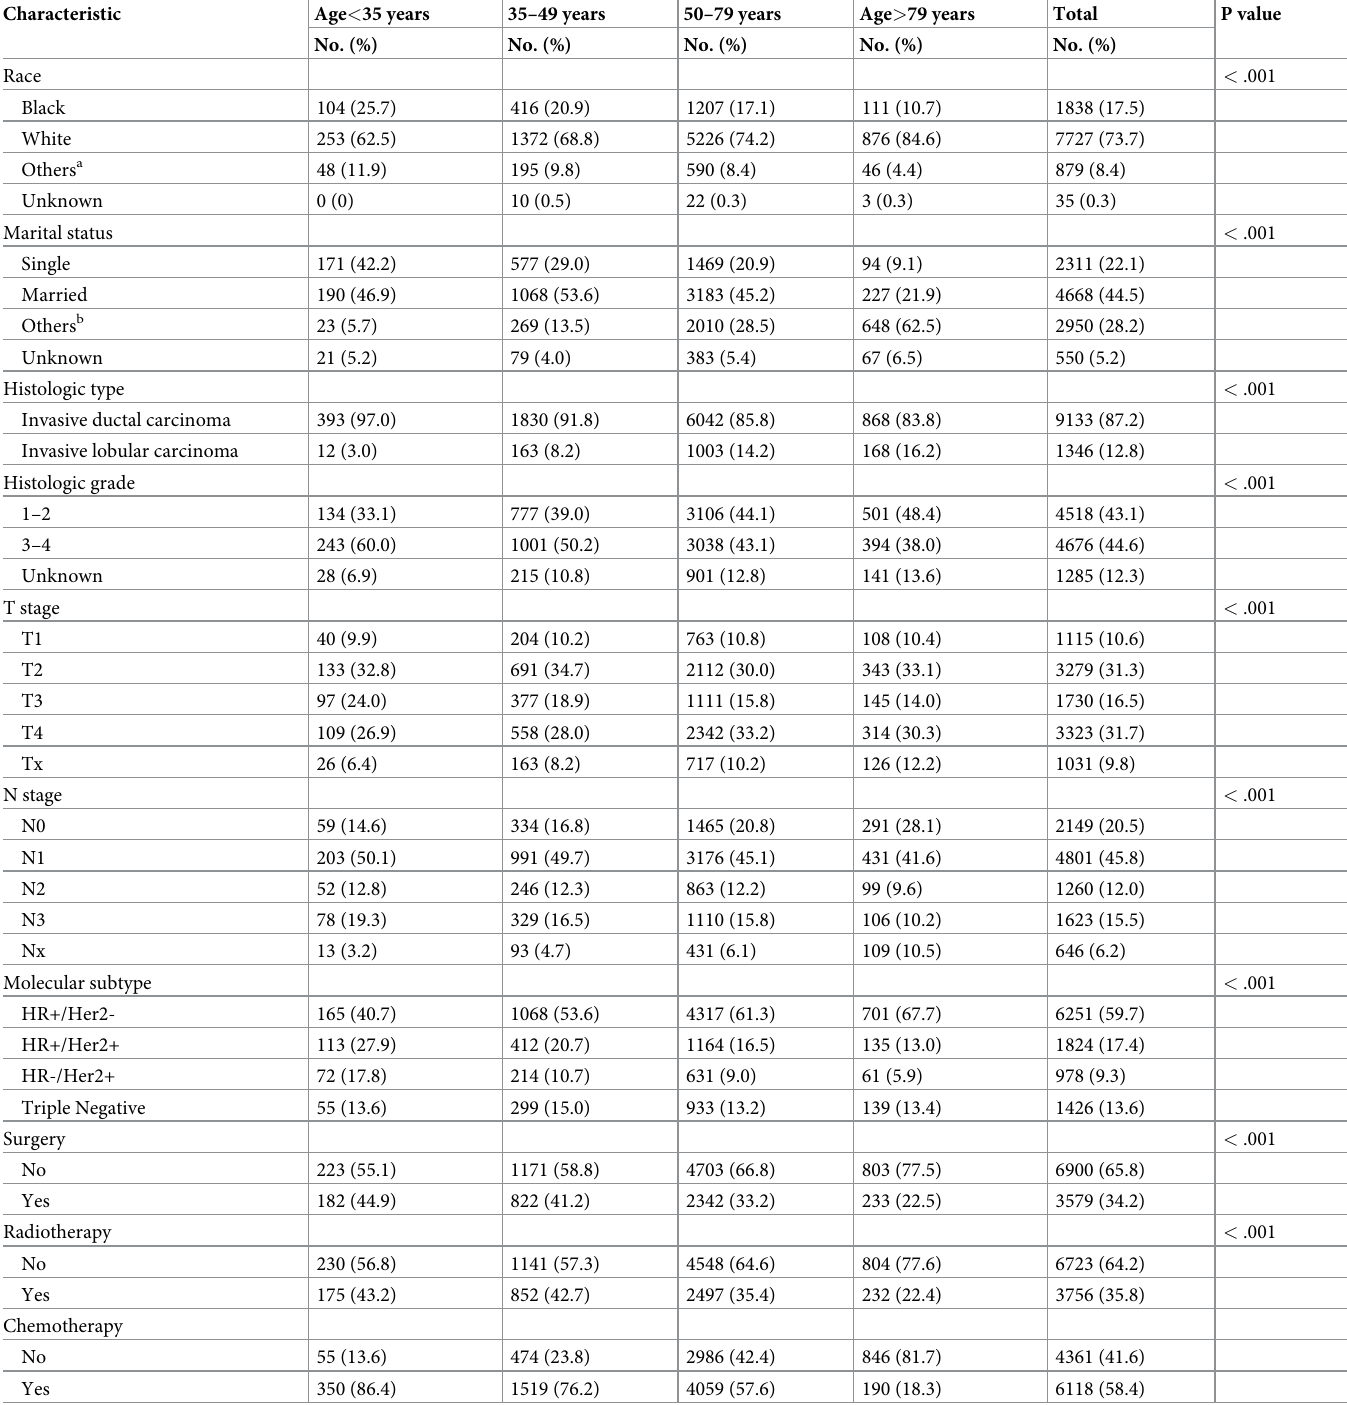
Table 1. Characteristics of patients with metastatic breast cancer by age